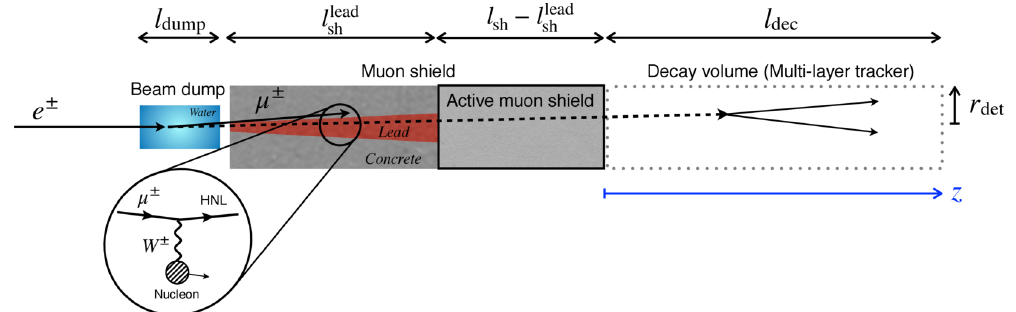
Figure 11 . A setup for the ILC-1000 beam dump experiment. It consists of the main beam dump, a muon lead shield, an active muon shield, a decay volume, and a detector. The HNLs can be produced by the DIS process for incoming muons in the muon lead shield with the length of l lead